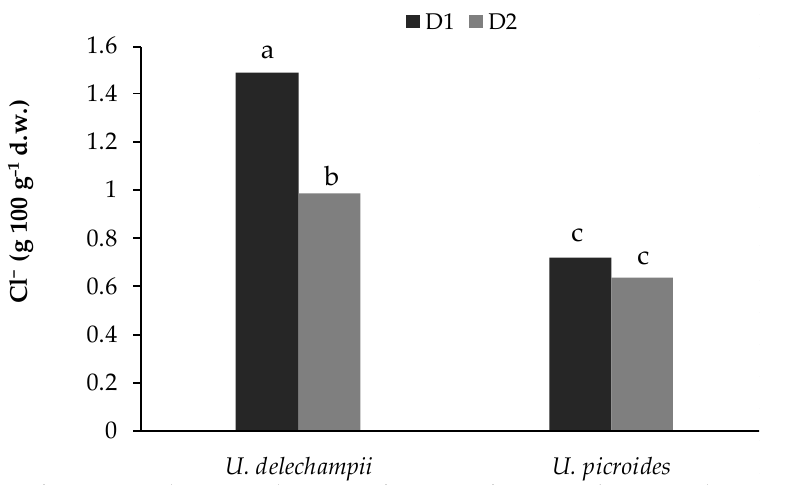
Figure 4. Chloride content in U. delechampii and U. picroides grown at two plant densities: 824 plants m −2 (D1) and 412 plants m −2 (D2). The same letters indicate mean values not significantly different ( p = 0.05).